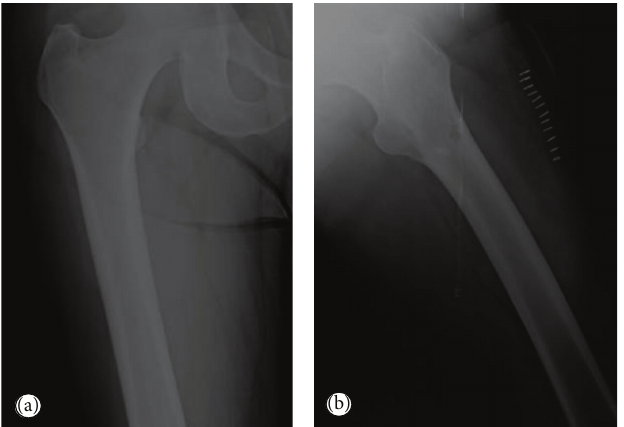
Figure 1: Anteroposterior radiographs of both femurs. (a) Mixed lytic-sclerotic lesions on the right femur. (b) Mixed lytic-sclerotic lesions on the left femur and a lytic destructive process with eccentric localization and a narrow zone of transition at diaphysis of the left femur extending to the left subtrochanteric region.